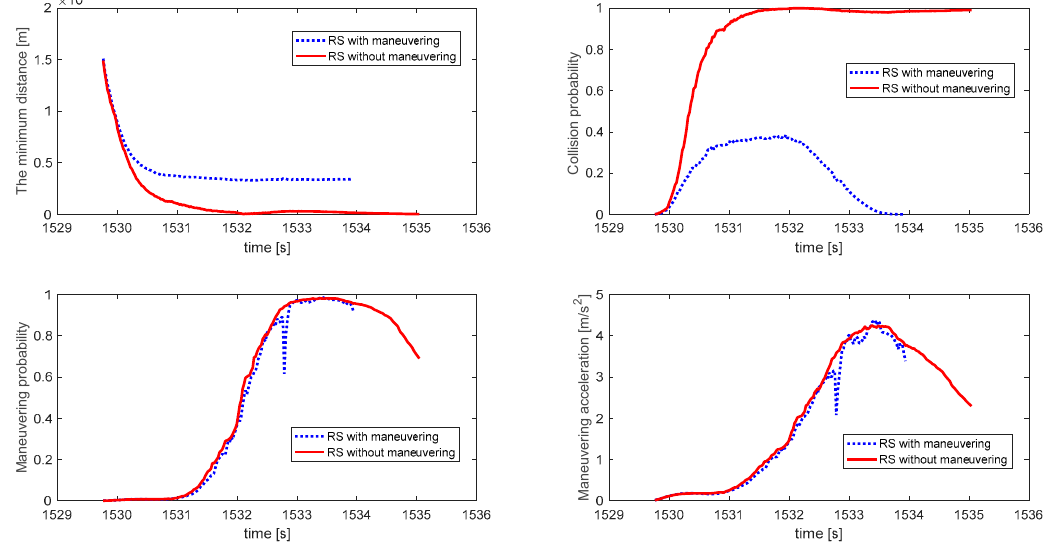
Figure 13. Minimum distances and collision probability between NCSO and RS, and maneuvering probability and maneuvering accelerations of NCSO for second simulation.